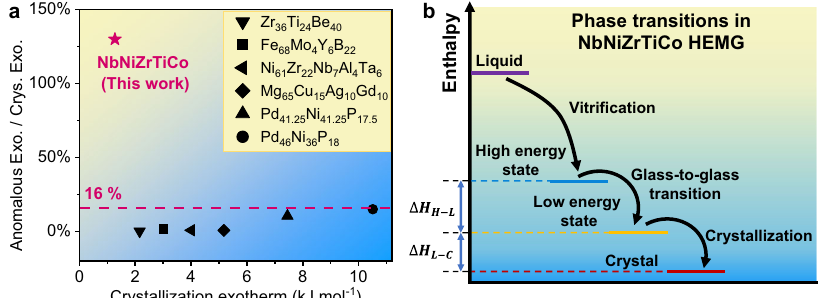
Fig. 5 The comparison with other MGs with AEPs and the schematic diagram of phase transitions. a The ratios of the anomalous exotherm to the crystallization exotherm of NbNiZrTiCo and other typical MGs with AEPs 15,71 – 75 . Anomalous Exo./Crys. Exo.: Anomalous exotherm/crystallization exotherm. b Upon fast cooling, the liquid could form a high-energy glass and transform into a low-energy glass by glass-to-glass transition and releasing energy ð Δ H H (cid:2) L Þ . The heat-treated glass could crystallize by further releasing energy ð Δ H L (cid:2) C Þ .